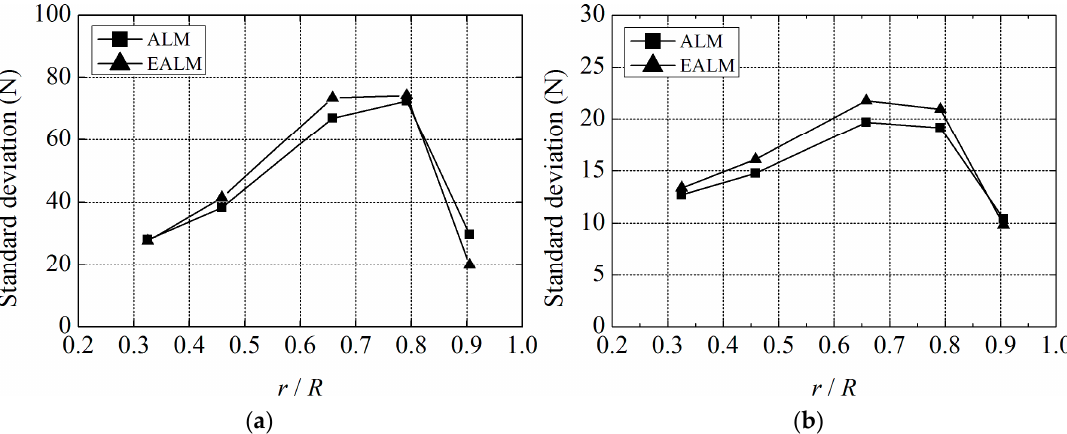
Figure 23. Stabilization of forces on downstream wind turbine blades: ( a ) normal force; and ( b ) tangential force